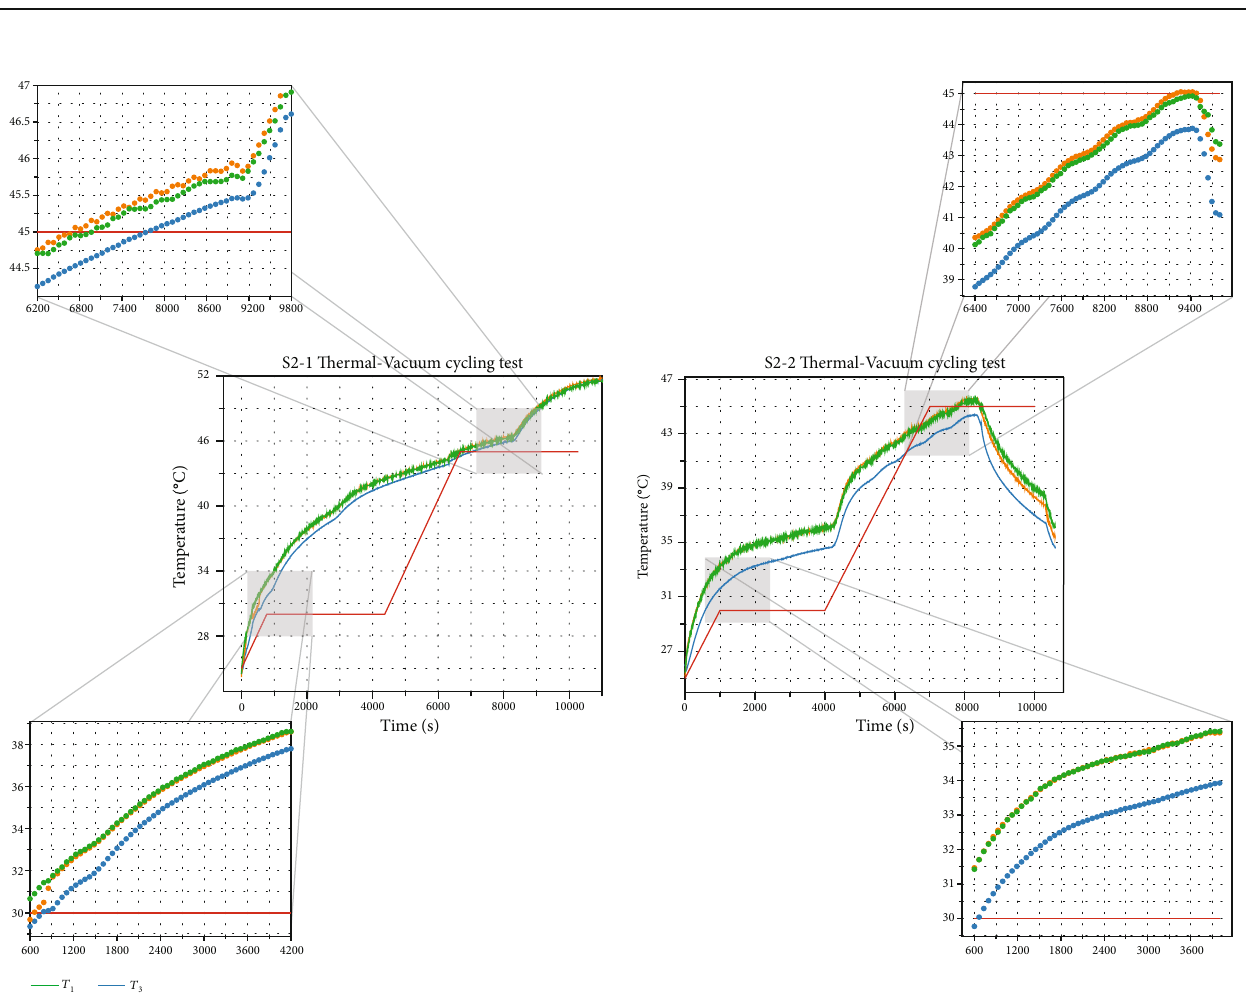
Figure 8: TVCT pro fi les of the units S2-1 and S2-2, corresponding to A and B treatments. The green, blue, and orange lines correspond to recordings to the sensors T